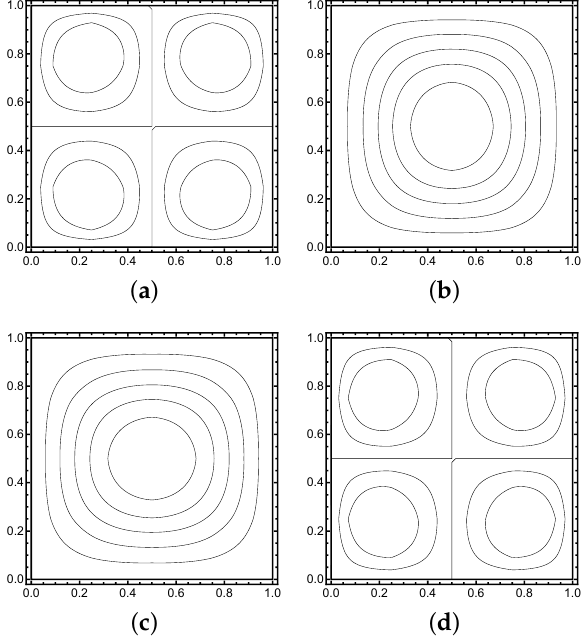
Figure 3. Effect of the perturbation of the Young’s modulus on the smallest eigenmode. Y m = − 1: { u } ; Y m = 1: { ˆ u } . ( a ) u 1 , u 2 1 , ˆ u 2 1 ; ( b ) u 2 ; ( c ) ˆ u 1 ; ( d ) ˆ u 2